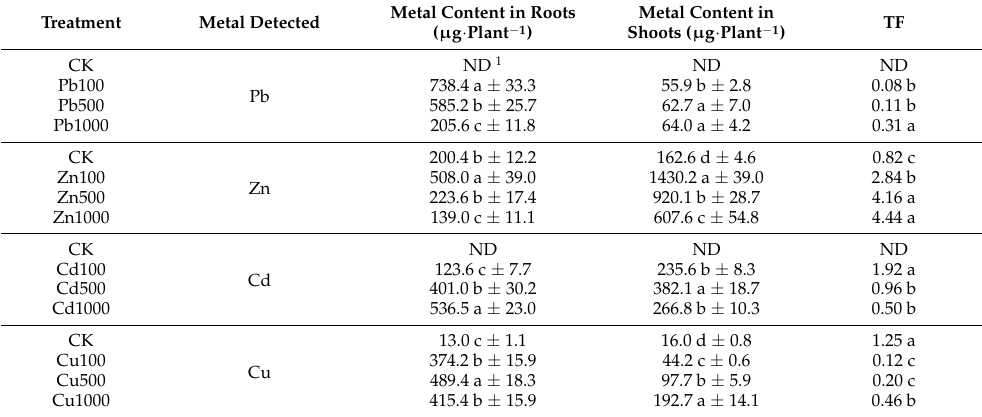
Table 2. Metal content and translocation factor (TF) per plant of M. cordata under control (CK) and different concentrations of Cd, Pb, Cu, and Zn after 20 days of